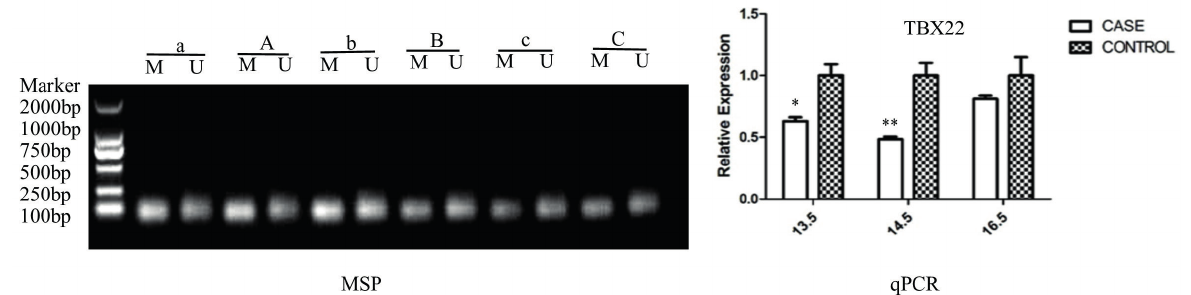
Figure 4 - MSP and qPCR were performed at E13.5, E14.5, and E16.5 in ATRA-treaded (case) vs . control. MSP: Genomic DNA was extracted from mouse palatal shelf tissues using a rapid DNA extraction kit. After quantification, each DNA sample was subjected to bisulfite modification using a DNA methylation modification kit and PCR amplification. The PCR products were then separated in a 2% agarose gel by electrophoresis, stained with ethidium bromide, and visualized under an ultraviolet illuminator. The distinct visible band of the amplicon with methylation-specific primers was considered the DNA methylation band, and the density of each band was analyzed using image analysis software (Gel-Pro 4.5) for quantitation. qPCR: The same RNA samples were used for reverse transcription. cDNA was synthesized using the Thermo First cDNA Synthesis Kit. The qPCR data are shown as the mean ± S.E.M, and the 2- ΔΔ Ct method was used to calculate the level of gene expression relative to the expression of β-actin, as an internal control. All reactions were carried out in triplicate for technical and biological repetitions ( n =18, 3 groups, 3 ATRA- treated samples vs . 3 control samples). ( a ): TBX22 exon 5 methylation level validation by MSP. The lengths of markers from top to bottom are 2000, 1000, 750, 500, 250, and 100 bp. “U” and “M” indicate unmethylated and methylated sites, respectively. Lane a-c: control; Lane A-C: ATRA-treated. ( b ): TBX22 exon 5 expression validation by qPCR. TBX22 exon 5 in ATRA-treated was obviously down-regulation compared with control at E 13.5 ( P =0.018) and at E 13.5 ( P =0.008), TBX22 exon 5 was no significant difference of expression level at E16.5 ( P =0.286). MSP, methylation‐specific polymerase chain reaction; qPCR, quantitative real‐ time